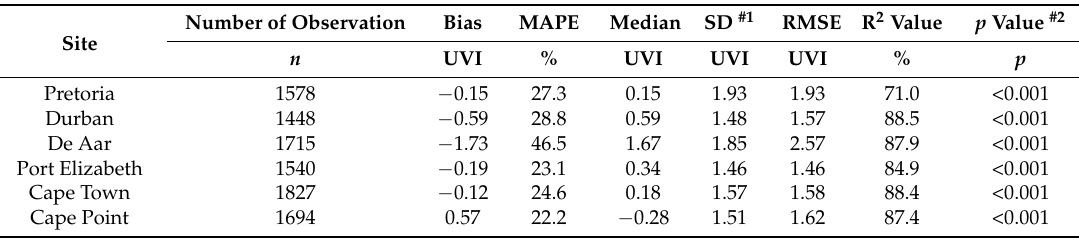
Table 2. Summary validation statistics for overpass UV index values (all available years) including bias, RMSE, and R 2 values for the comparison of ground-based solar UVR and satellite-derived solar UVR (statistics computed only for clear sky day selected with